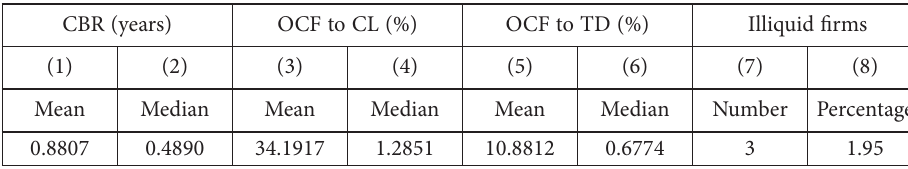
Table 2. Stress tests of the CBR, the OCF to CL ratio, and the OCF to TD ratio for the two simulated distress scenarios of 50% and 75% sales decrease Panel A: Principal scenario – no sales